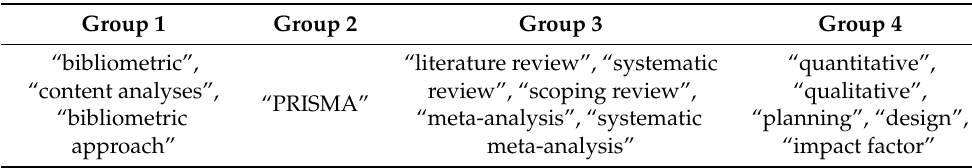
Table 2. The keywords for searching within scientific journals.